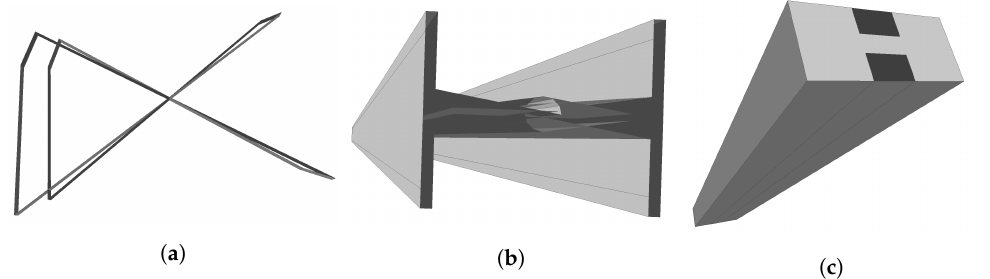
Figure 6. Some of the errors present in the test IFC files. ( a ) A prismatic polyhedron with an obvious self-intersection. The self-intersecting top and bottom faces of the polyhedron are not shown. ( b ) A self-intersecting representation of a beam. ( c ) A topological manifold that contains non-obvious geometric intersections. The bottom of the polyhedron, seemingly composed of three rectangular faces, actually has only two rectangular faces that overlap along the middle